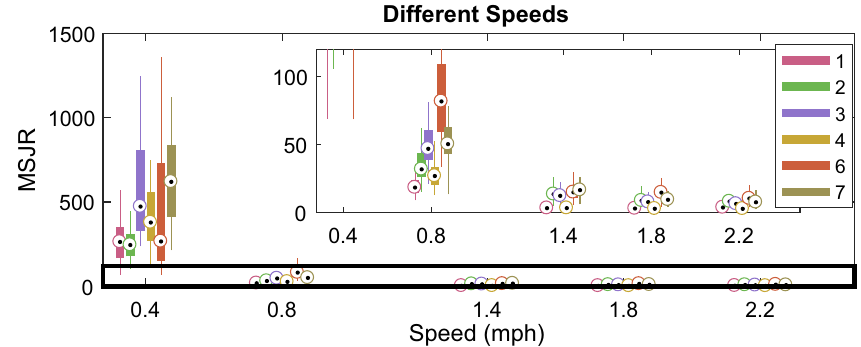
(a) Level walking at five different speeds: 0.4mph(0.65km/h), 0.8mph(1.29km/h), 1.4mph(2.25km/h), 1.8mph(2.90km/h) and 2.2mph(3.54km/h). Inner plot is zoomed to MSJR= ( 0 , 120 ) range. Data from Subject 5 was invalid in these trials and therefore not used (see Supplementary Table S1).